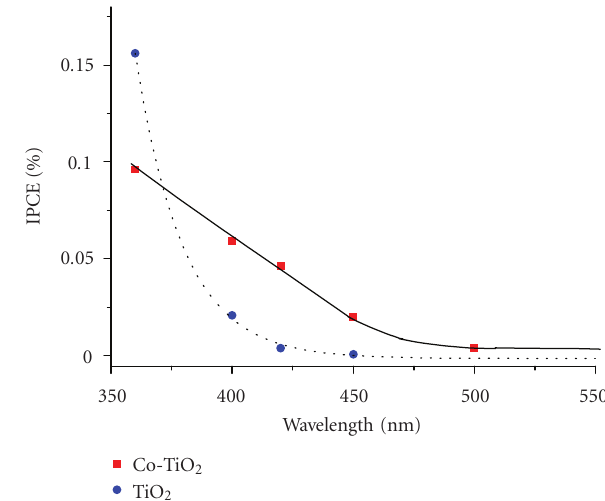
Figure 4: Photoaction spectra recorded from photocurrent-time transients using TiO 2 and Co(0.5%)-TiO 2 electrodes in 1M NaClO 4 solutions. Electrodes geometric area: 2 cm 2 .